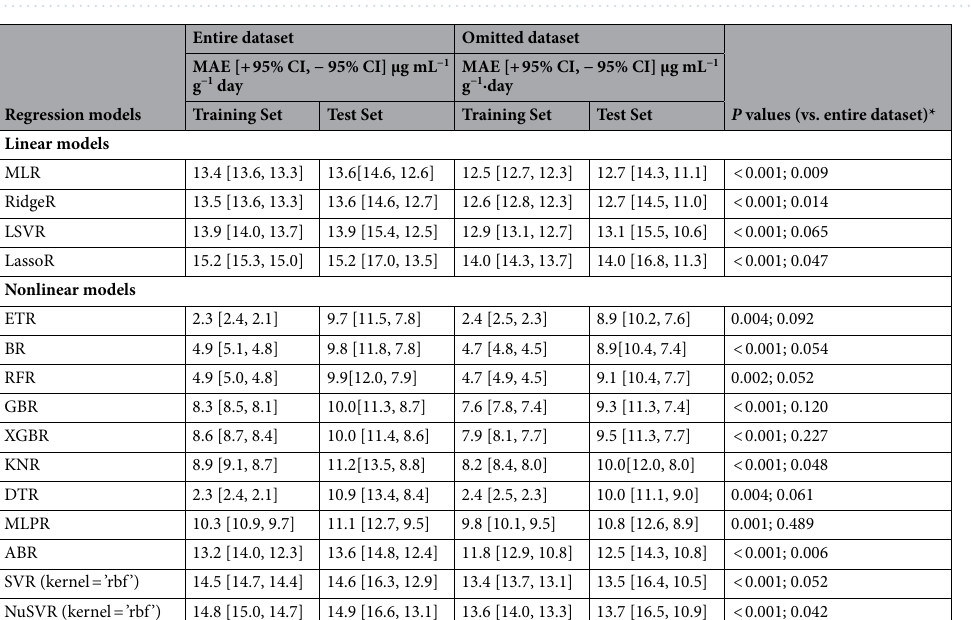
Figure 1. Heatmap visualization of the correlations between the dose-adjusted concentrations (C/D ratio) and the variables analyzed by Pearson’s correlation coefficient. BW body weight, VPA valproic acid, CBZ carbamazepine, OXC oxcarbazepine, PB phenobarbitone, PHT phenytoin, IND enzyme inducers.